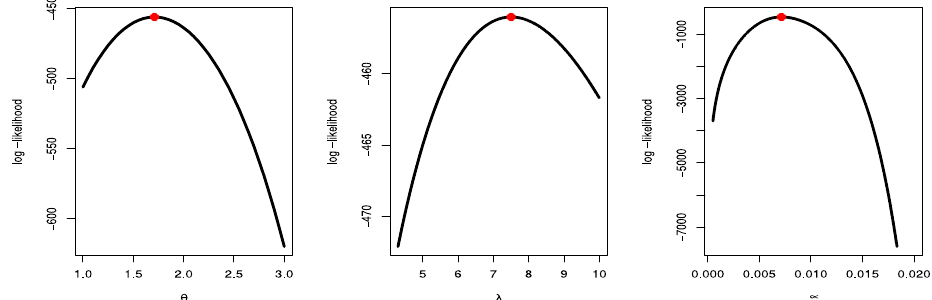
Figure 13. Likelihood profile for parameters of TCPWE distribution for fatigue times.